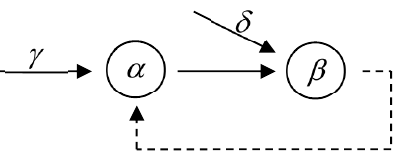
Figure 2. A system with positive and negative customers.